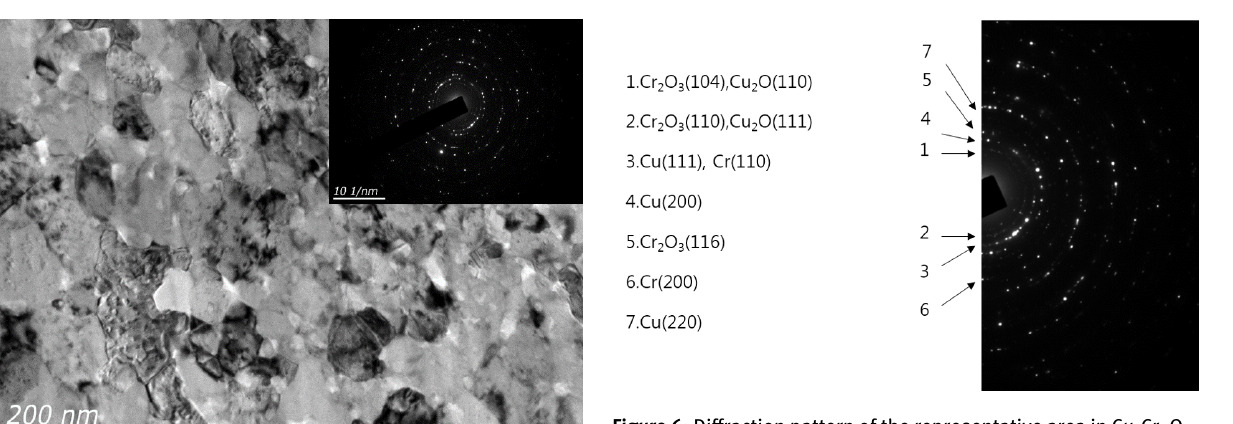
Figure 6: Diffraction pattern of the representative area in Cu-Cr 2 O 3 with lattice plane indices and corresponding